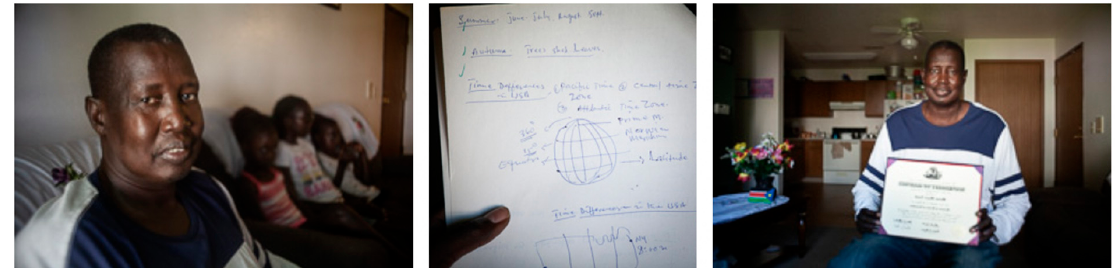
Figure 5. Malual. Malual fled civil war in Sudan in the late 1980s and sought refuge in Liberia until a civil war in that country led to him being granted refugee status in the United States in the mid-1990s. He is pictured here sitting at home with his three daughters, holding a page of notes he wrote as part of a course he took in Liberia to prepare for life in the U.S., and with his college diploma.